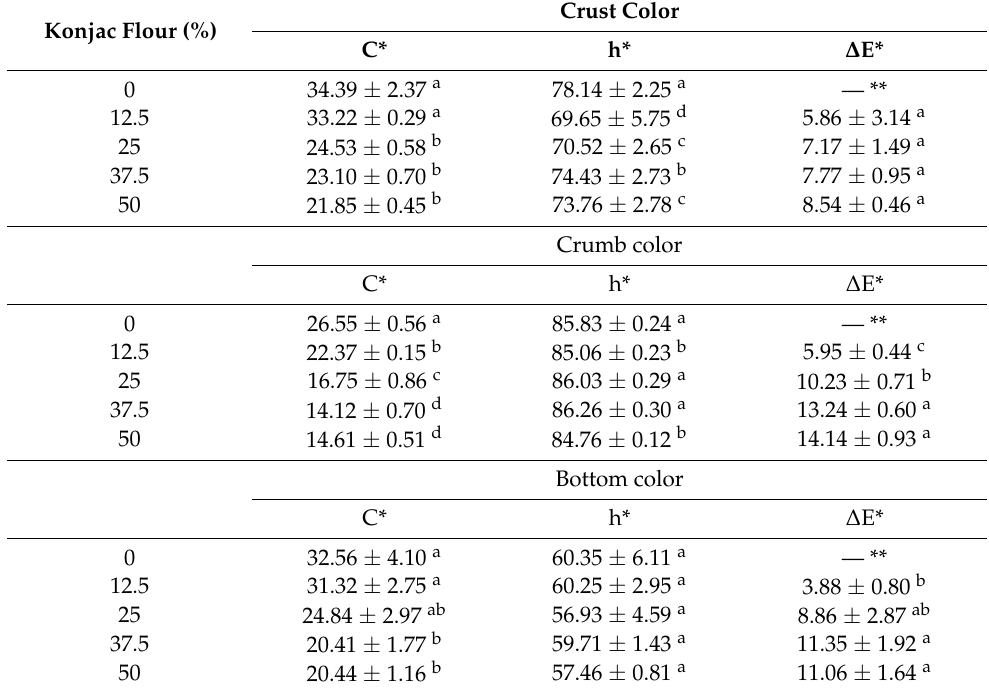
Table 4. Mean values of chroma (C*), tone color (h*), and color difference ( ∆ E*) of bread formulations prepared with different concentrations of konjac